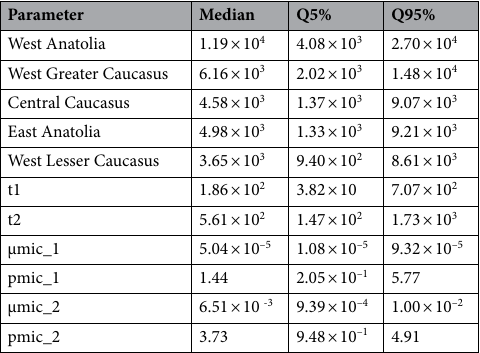
Parameter Median